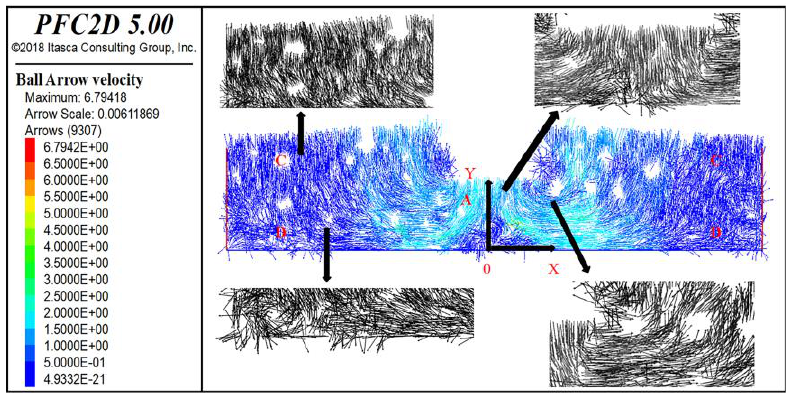
Figure 11. Coarse aggregate distribution after loading.